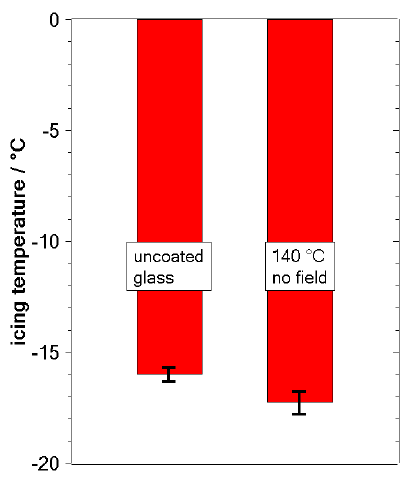
Figure 5. Freezing temperature on P(VDF-TrFE)-coated glass after a thermal treatment at 140 °C with no electric field applied. A comparison is made to uncoated glass.